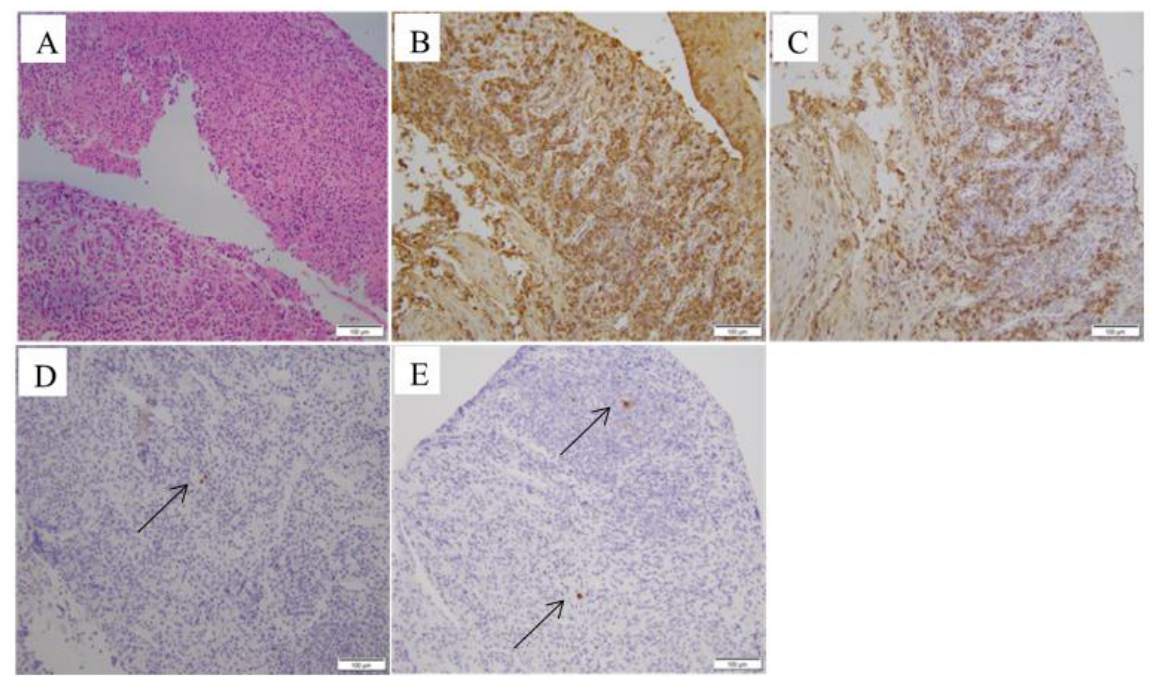
Figure 3. Pathological findings. ( A ). The oesophageal specimen revealed infiltration by lymphocytes, plasma cells, and eosinophils (H&E; × 100). ( B ). Immunoglobulin G (IgG) immunohistochemical staining showing increased numbers of IgG-positive plasma cells in the oesophagus lesions (HPF; × 100). ( C ) Dense infiltration of IgG4-positive plasma cells (HPF; × 100). ( D , E ) Immunohistochemical staining using anti-CMV monoclonal antibodies was positive (HPF; × 100) (black arrow). Furthermore, his serum IgG4 levels were 4.05 g/L, validating his diagnosis of IgG4-RD with cytomegalovirus infection. The patient was treated with a proton pump inhibitor (PPI) and blood transfusions, and he was administered 0.25 g/q 12 h ganciclovir intravenously for 2 weeks. His haemoglobin was higher than before, and gastroscopy at follow-up after 2 weeks showed that the oesophageal ulcers had begun healing (Figure 4). He was discharged with a marked improvement in